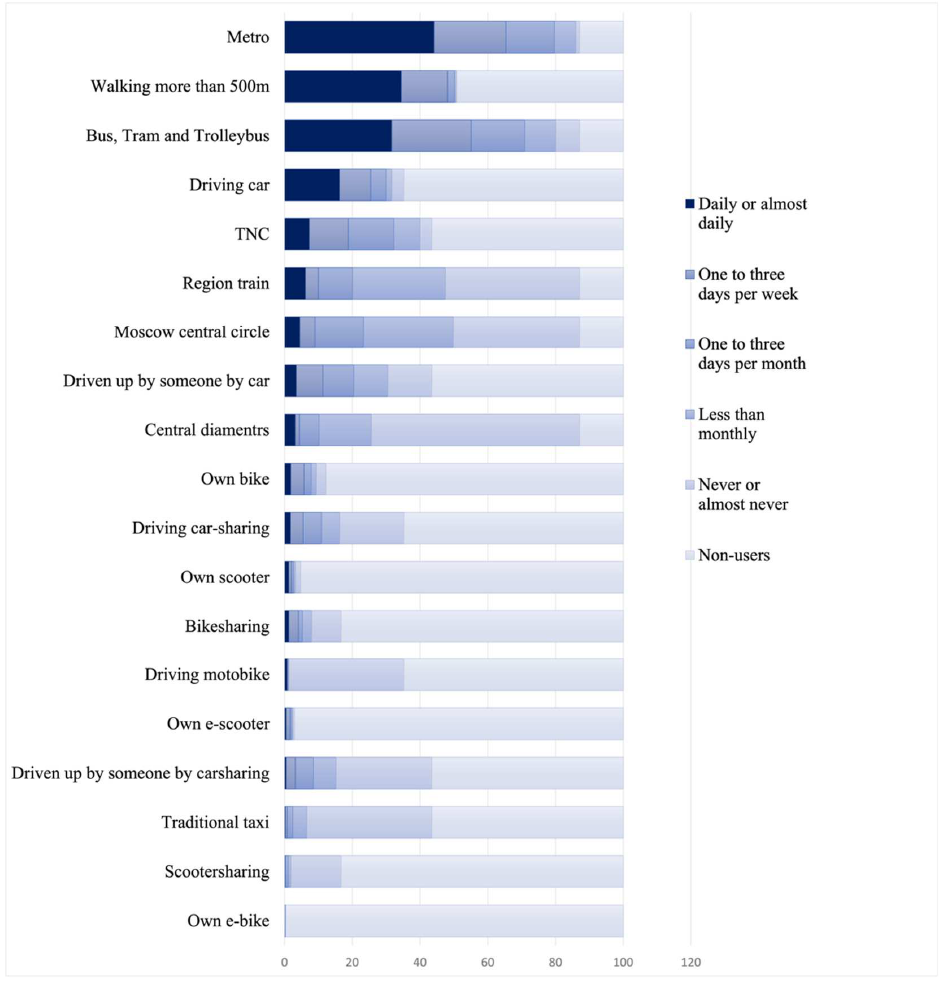
Figure 4. Frequency of usage of different means of transport in Moscow (N =